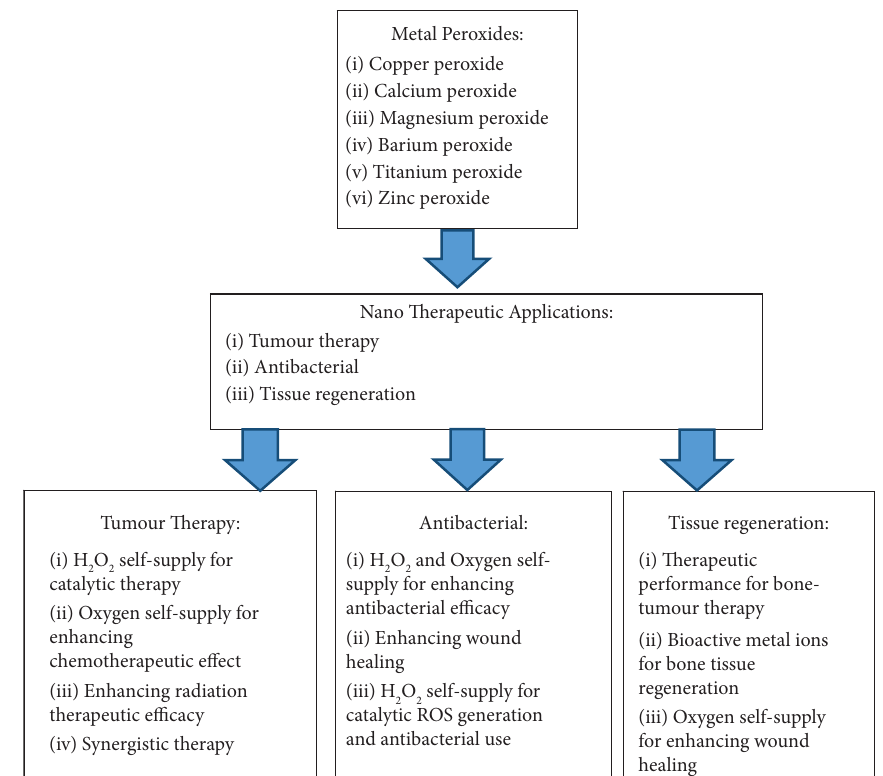
Figure 2: Applications for various metal peroxide nanotherapeutics.